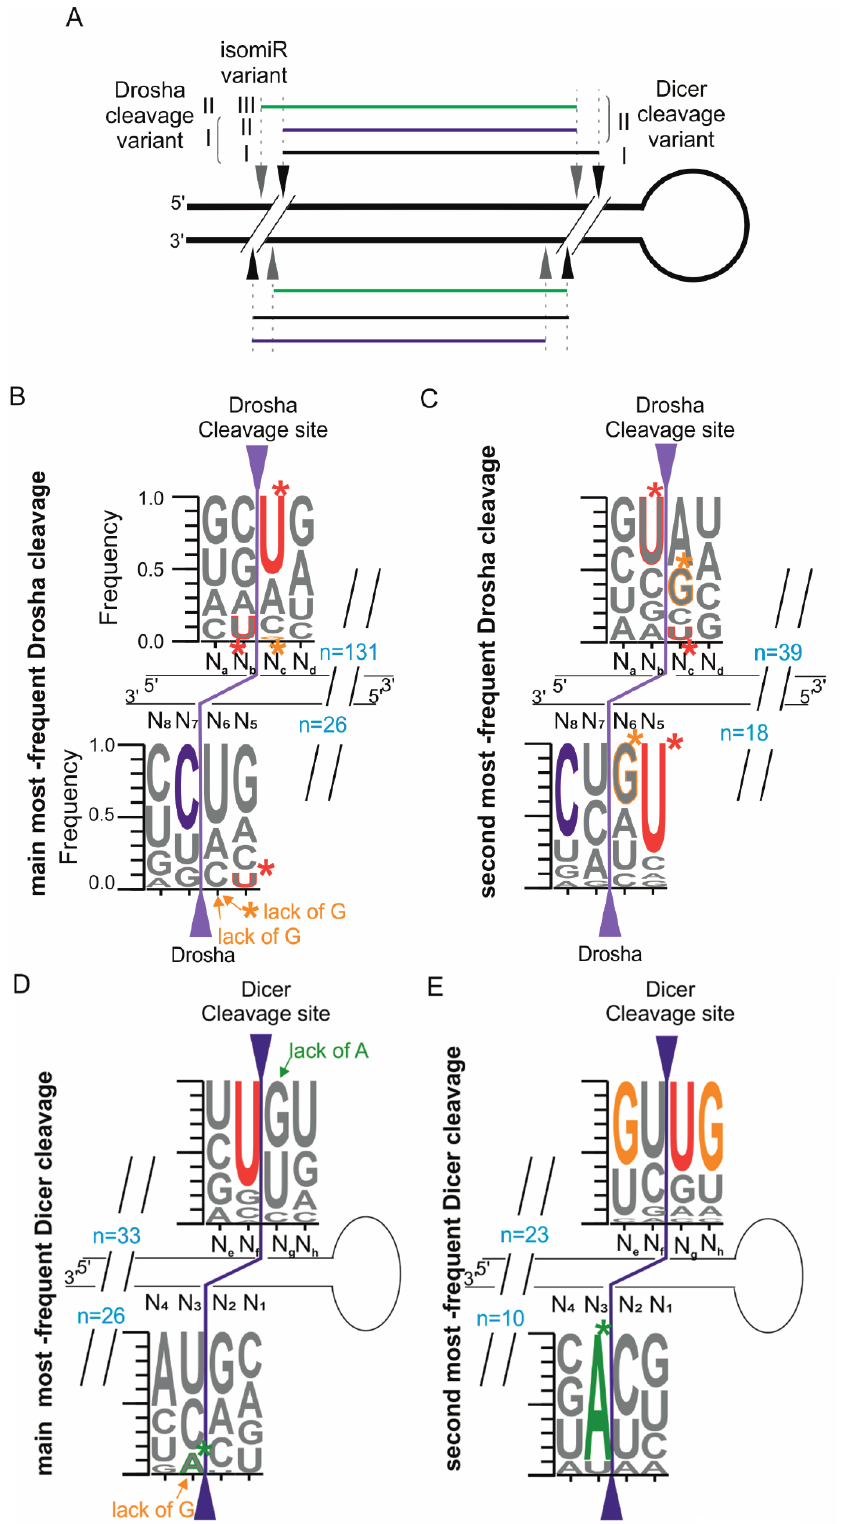
Figure 3. Sequence specificities of the nucleases Drosha and Dicer. ( A ) Relationship between the cleavage sites and the generated miRNA variants. A similar description as for the 5' arm should be applied to the 3' pri-miRNA arm; ( B – D ) The nucleotide frequencies that were observed at hairpin positions surrounding the Drosha and Dicer cleavage sites are presented as WebLogo sequences. Separate analyses were performed for the main ( B )